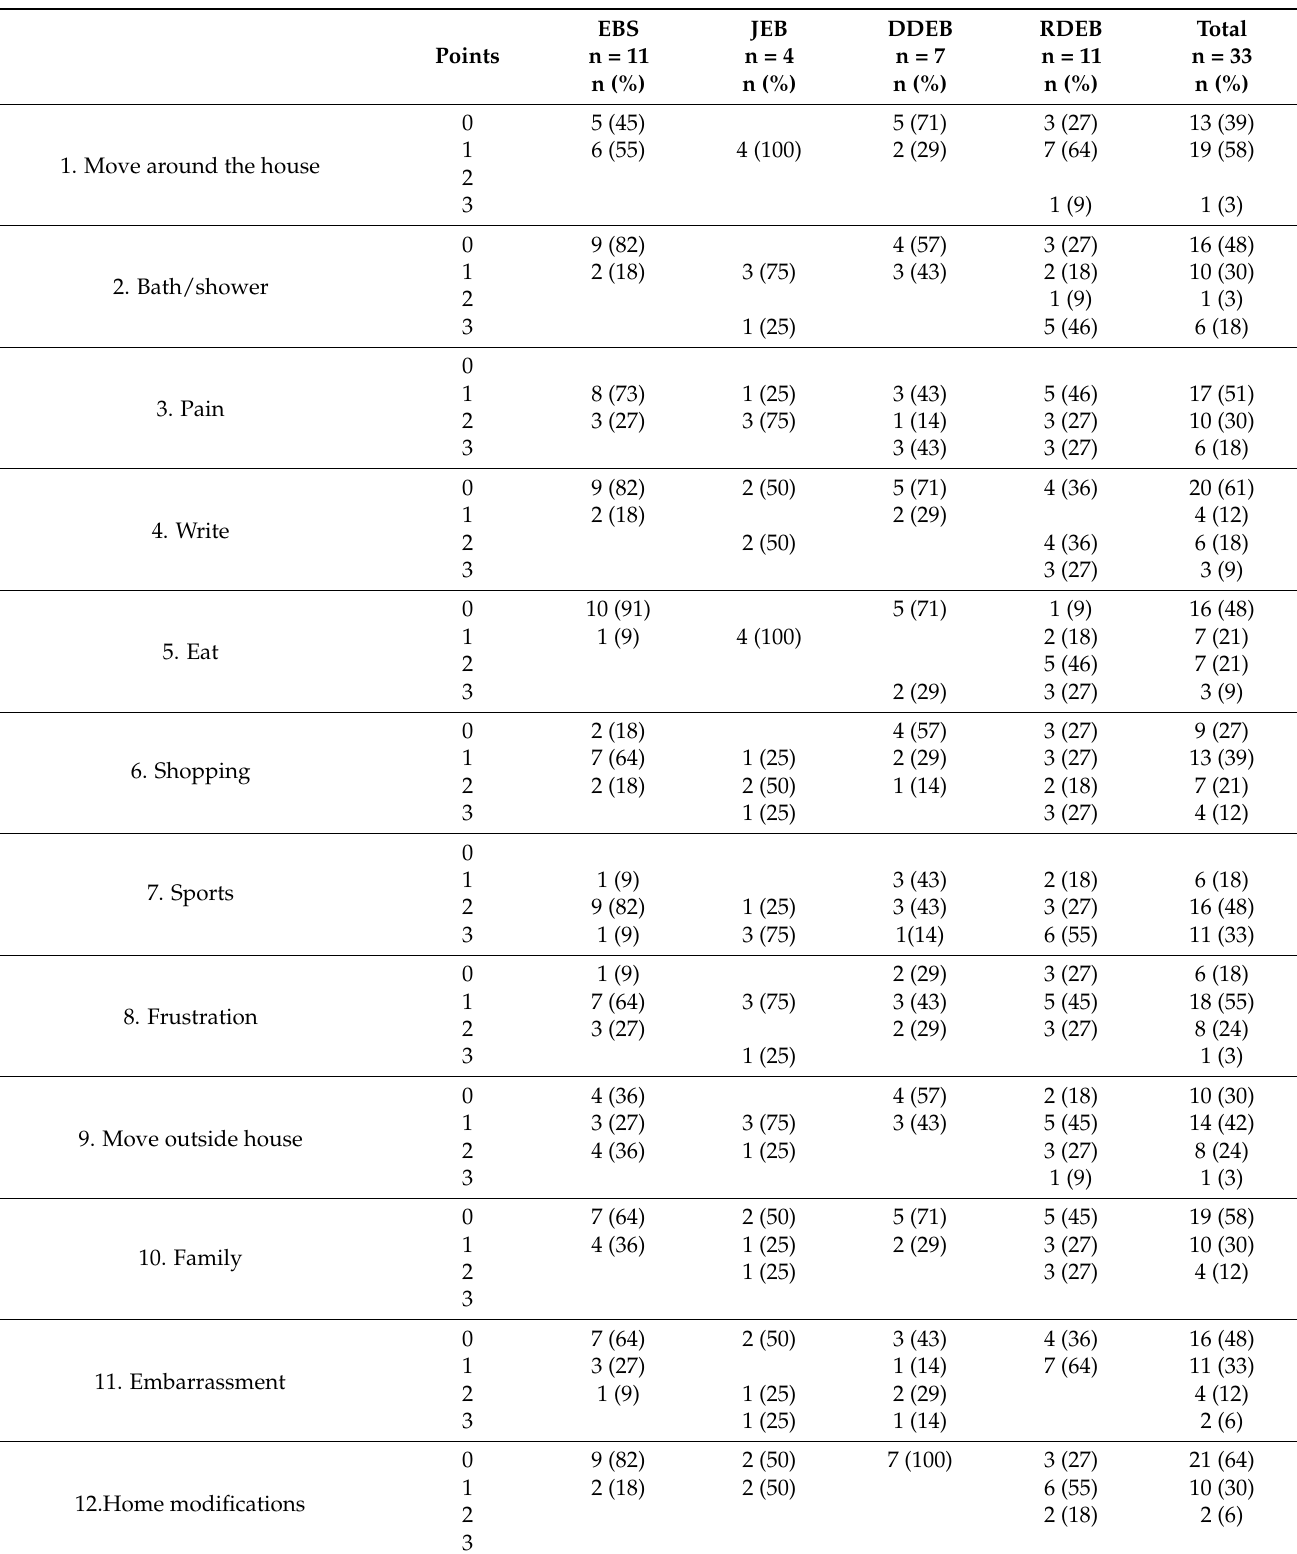
Table 4. Results of the 17 Spanish QoLEB questions, by EB